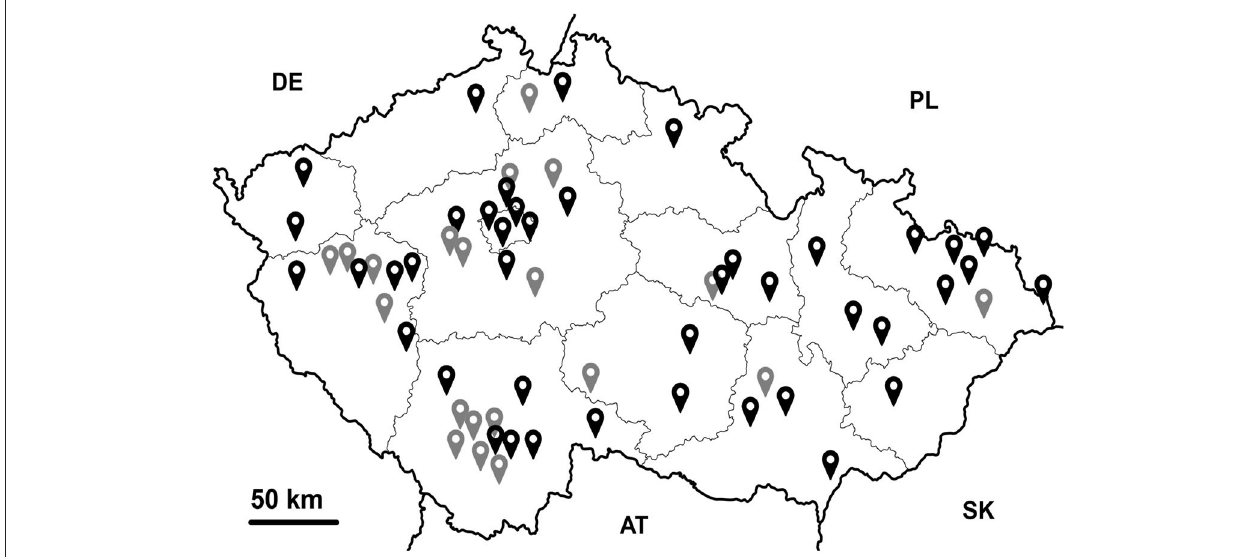
FIGURE 1 | Graphical visualization of regions/localities of the Czech Republic from which samples were obtained. Black indicates samples taken from cities, gray samples from villages.